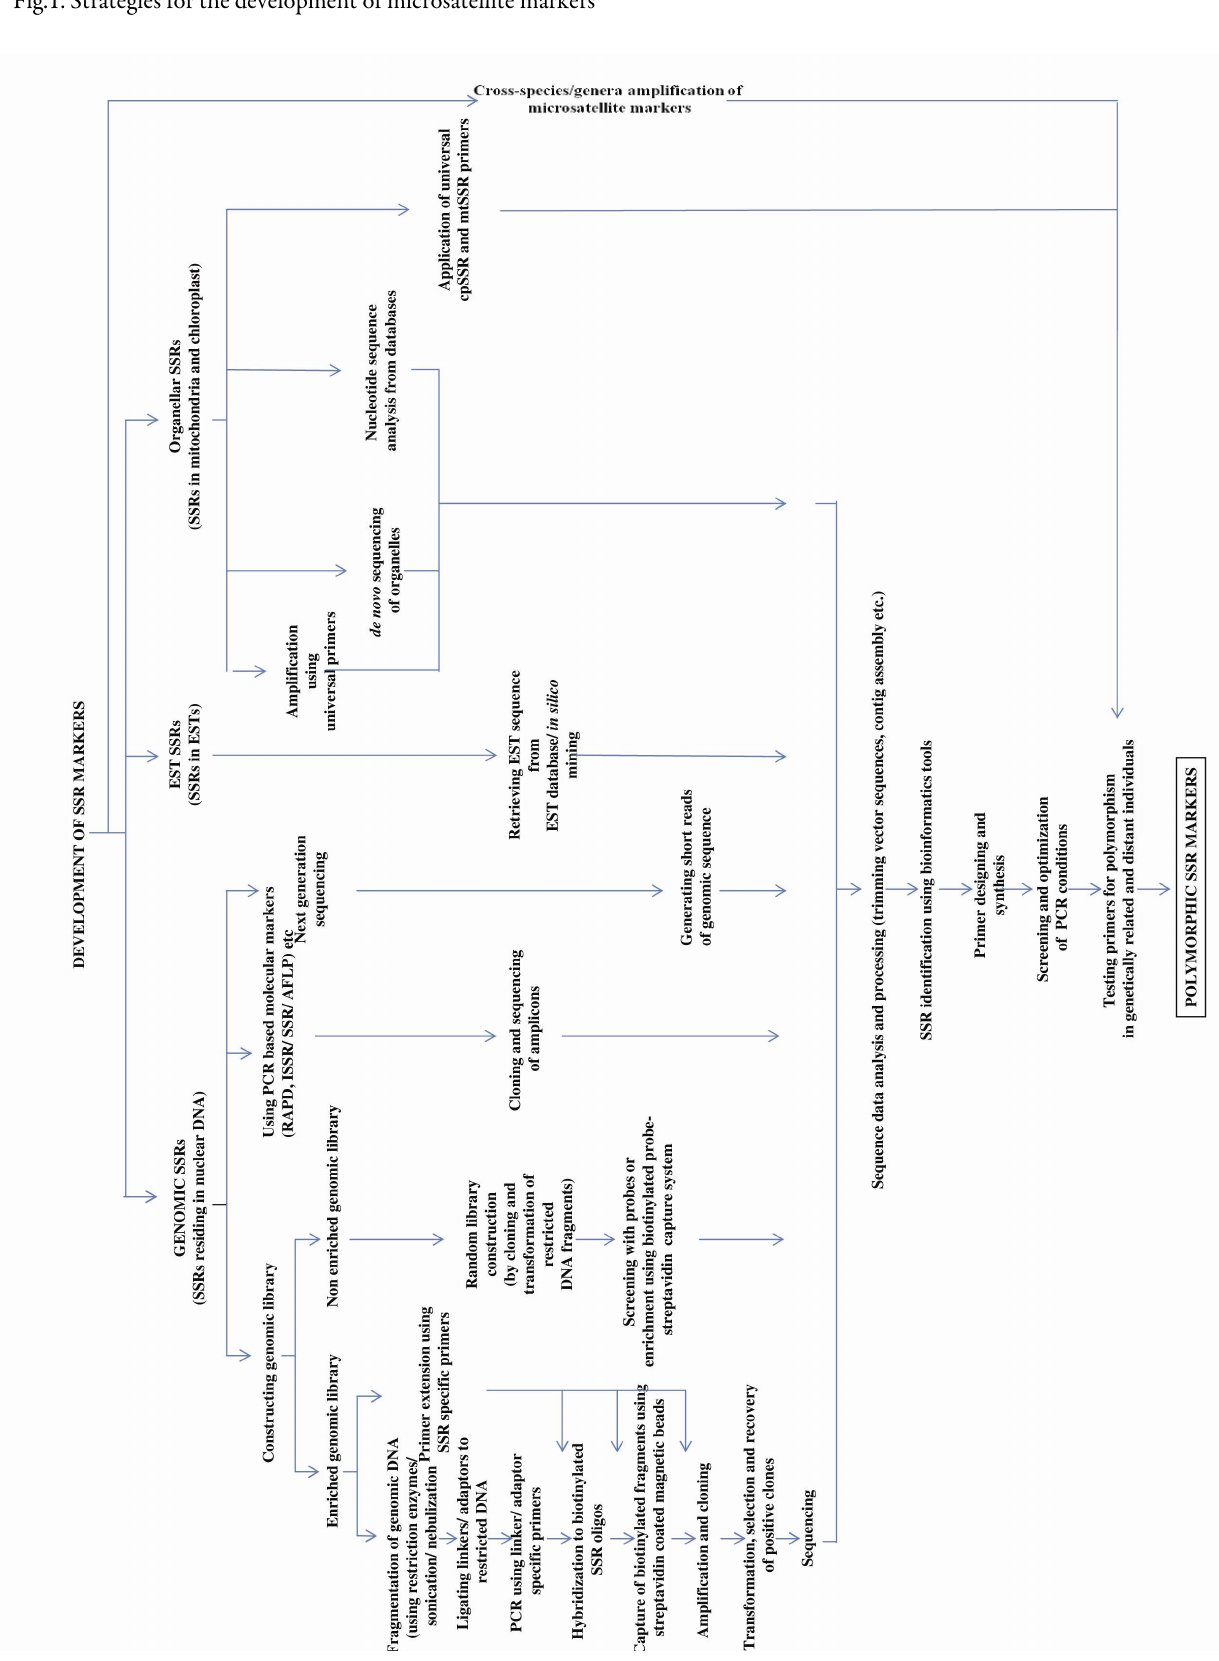
Fig.1. Strategies for the development of microsatellite